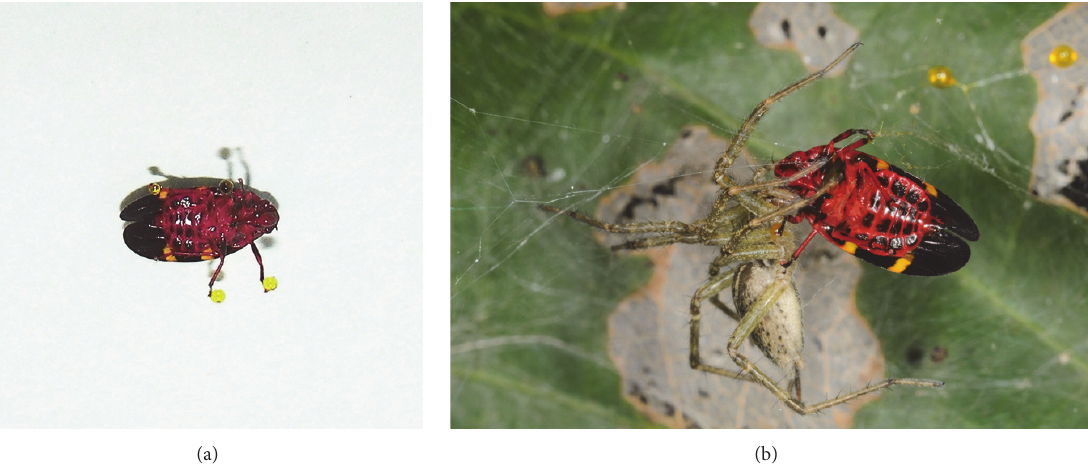
Figure 4: Reflex bleeding in Prosapia bicincta : (a) droplets of yellow liquid emanating from tarsi, photograph by Sam Houston; (b) bleeding in response to attack by spider (see droplet of yellow liquid on front tarsus to left in picture and another droplet caught in the spider web in the background), photograph by Andy Williams.